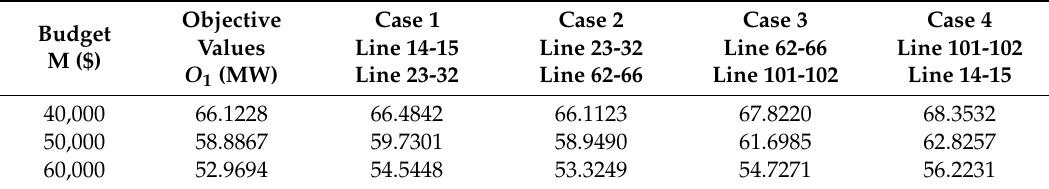
Table 11. Results for two outages on the IEEE 118-bus system.